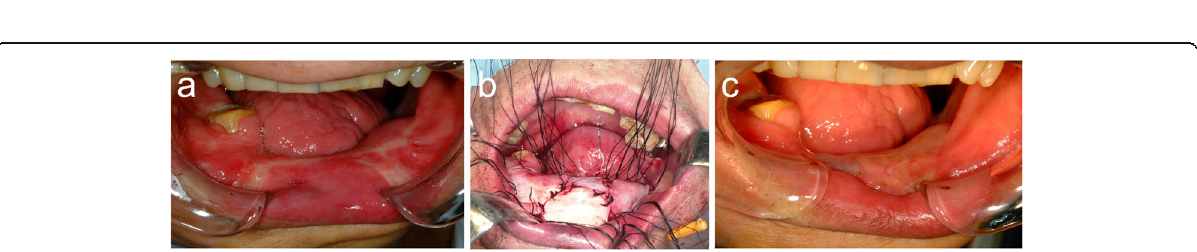
Fig. 6 a Intraoral view 7 months after vertical distraction osteogenesis of the free revascularized fibula flap. b Vestibular extension of the free revascularized fibula flap using an ex-vivo produced oral mucosa equivalent. c Intraoral view 2 months after vestibular extension